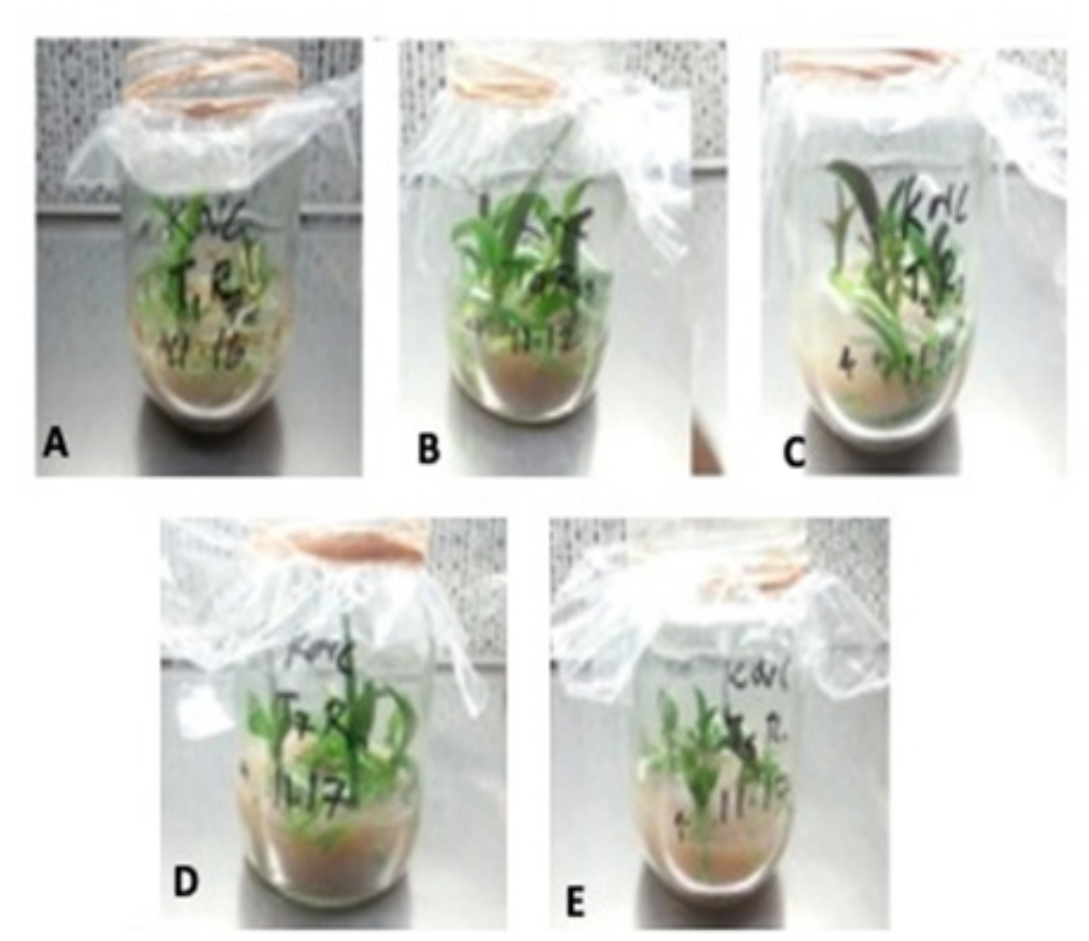
Figure 3. Growth of Cattleya seedlings in different mediums of KNC A-Sago, B-Semolina, C-Corn flour, D-Agar, E-KNC control media